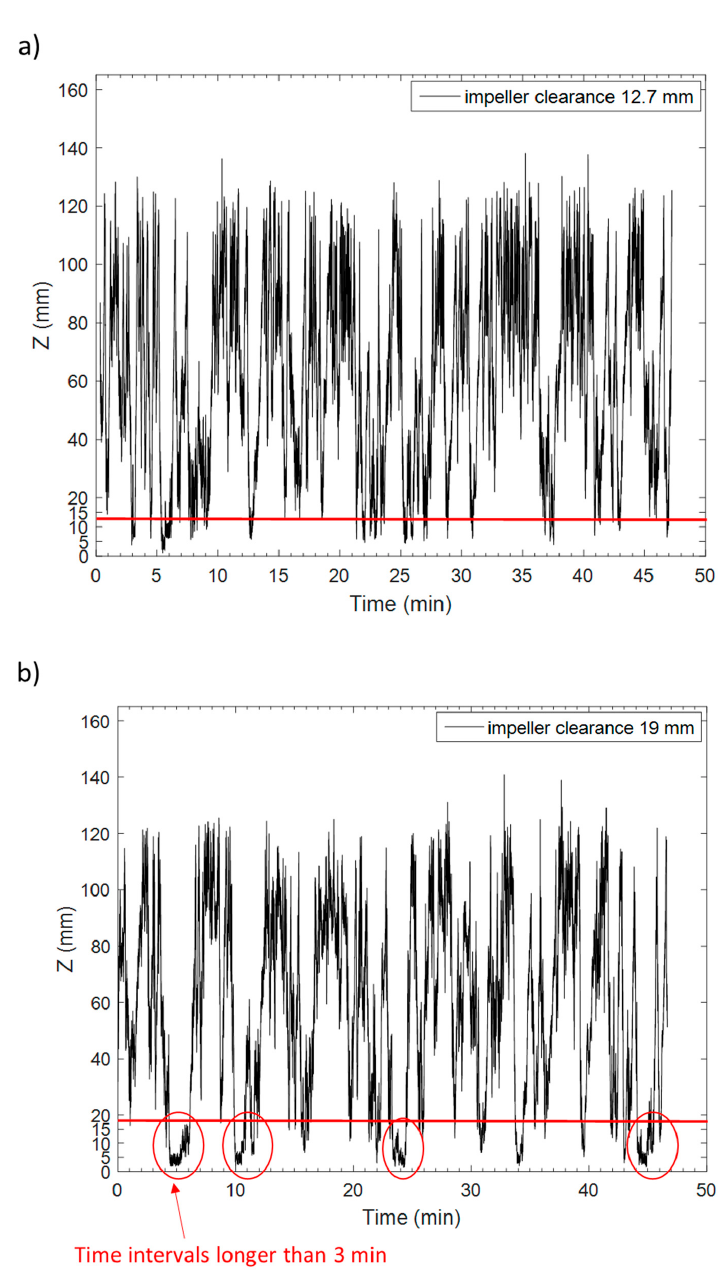
Figure 10. Axial tracer position (Z) as function of the time of the PEPT experiments for two impeller clearance values: ( a ) 12.7 mm and ( b ) 19 mm. The impeller position is represented by the red straight line.